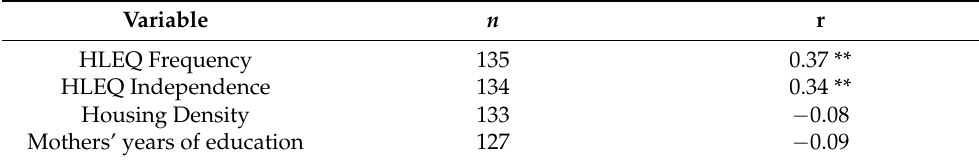
Table 4. Pearson correlation coefficients between the GIFT total scores and the environmental factors. Variable n